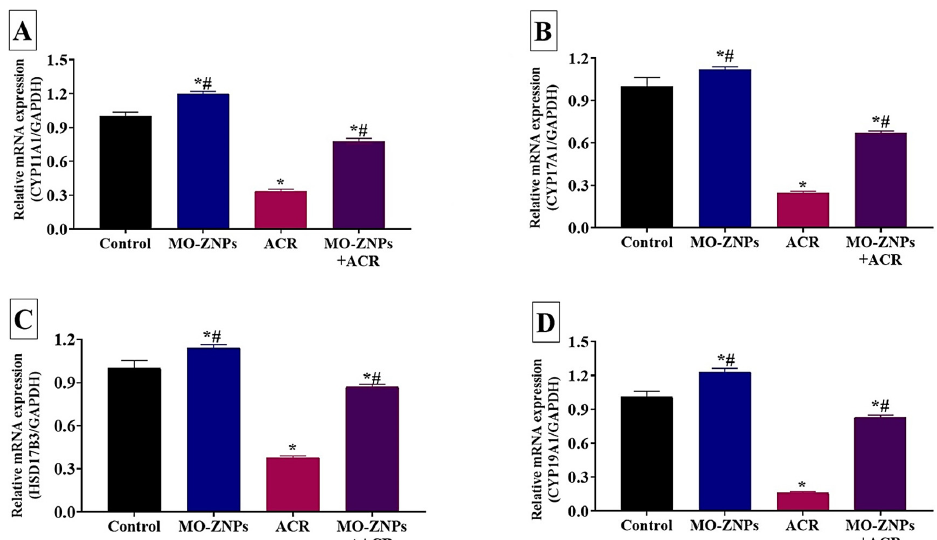
Figure 6. Effect of acrylamide (ACR) delivered orally (20 mg/kg) and/or zinc oxide nanoparticles synthesized by M. oleifera (MO-ZNPs) delivered orally (10 mg/kg bwt/day, 60 days) on mRNA expression of CYP11A1 ( A ), CYP17A1 ( B ), HSD17B3 ( C ), and CYP19A1( D ). Bars represent the mean ± SE. n = 10 replicates/treatment. * p < 0.05 vs. control. # p < 0.05 vs. ACR.